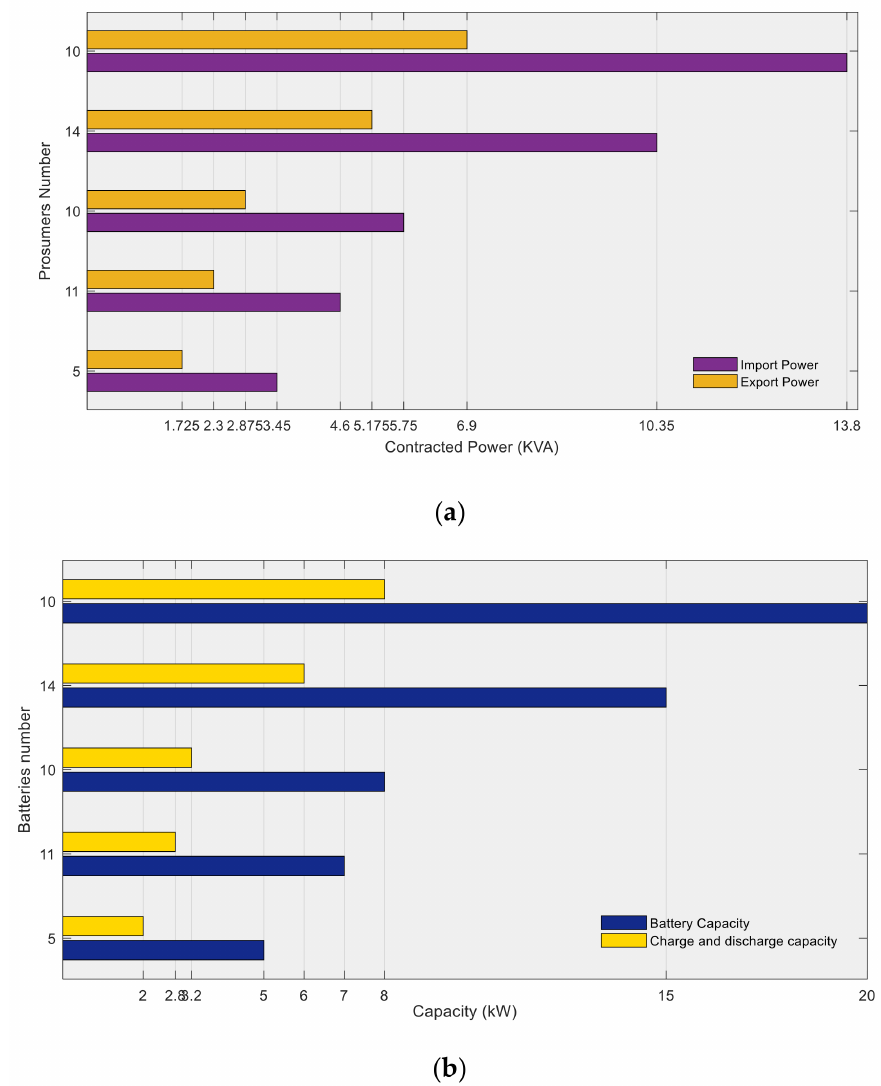
Figure 7. Prosumers characteristics, ( a ) Contracted power limits and ( b ) batteries